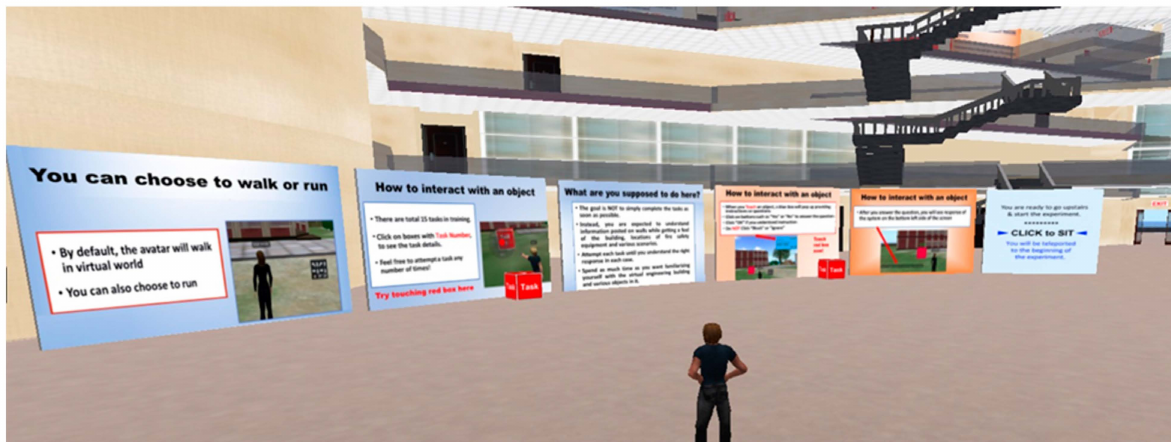
Figure 9. Emphasis on text to provide guidelines for the